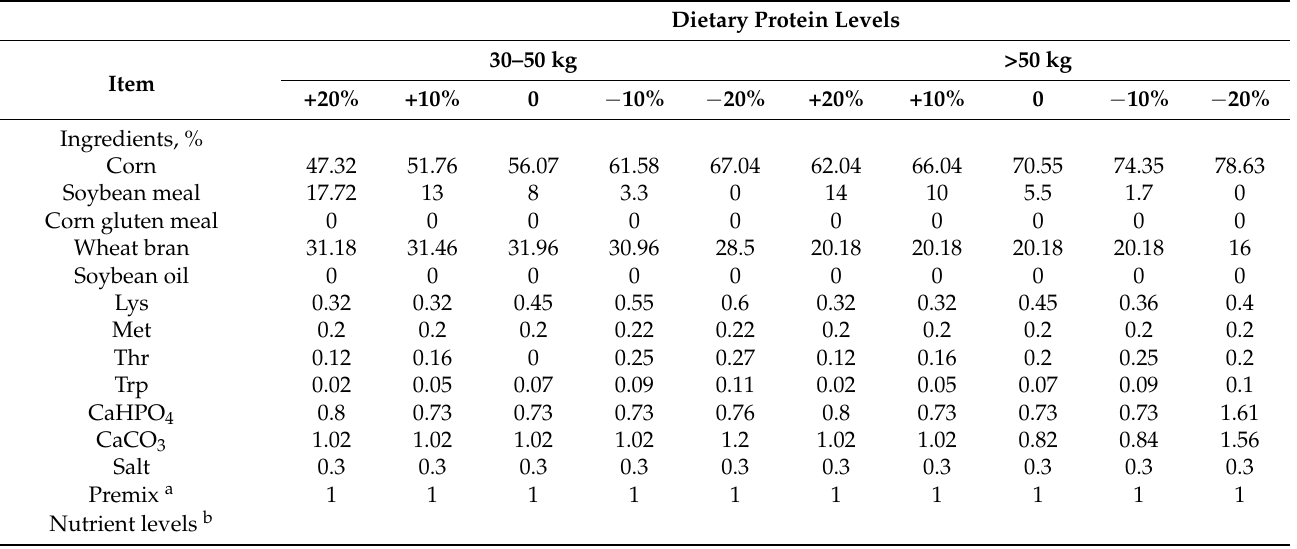
Table 2. Ingredients and nutrient levels of the experimental diets for Shaziling pigs (30~50 kg and >50 kg) (air-dried, %). Dietary Protein